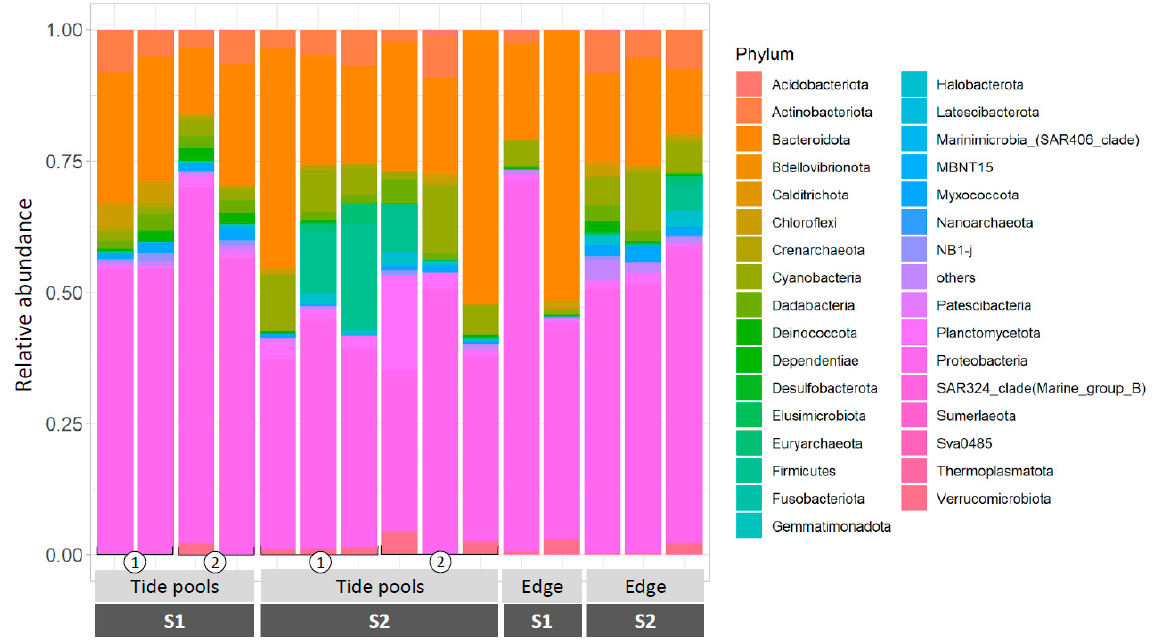
Figure 3. Relative abundance of ASVs associated with Neogoniolithon sp., phylum-level. Rock samples were taken from the platform edge and tidal pools during sampling 1 (S1) and sampling 2 (S2), followed by DNA extraction of suspensions of Neogoniolithon sp.-scraped tissues. Values represent the fraction from total ASVs identified in each sample. Asterisks denote samples demonstrating composition variance compared with their associated replicates.